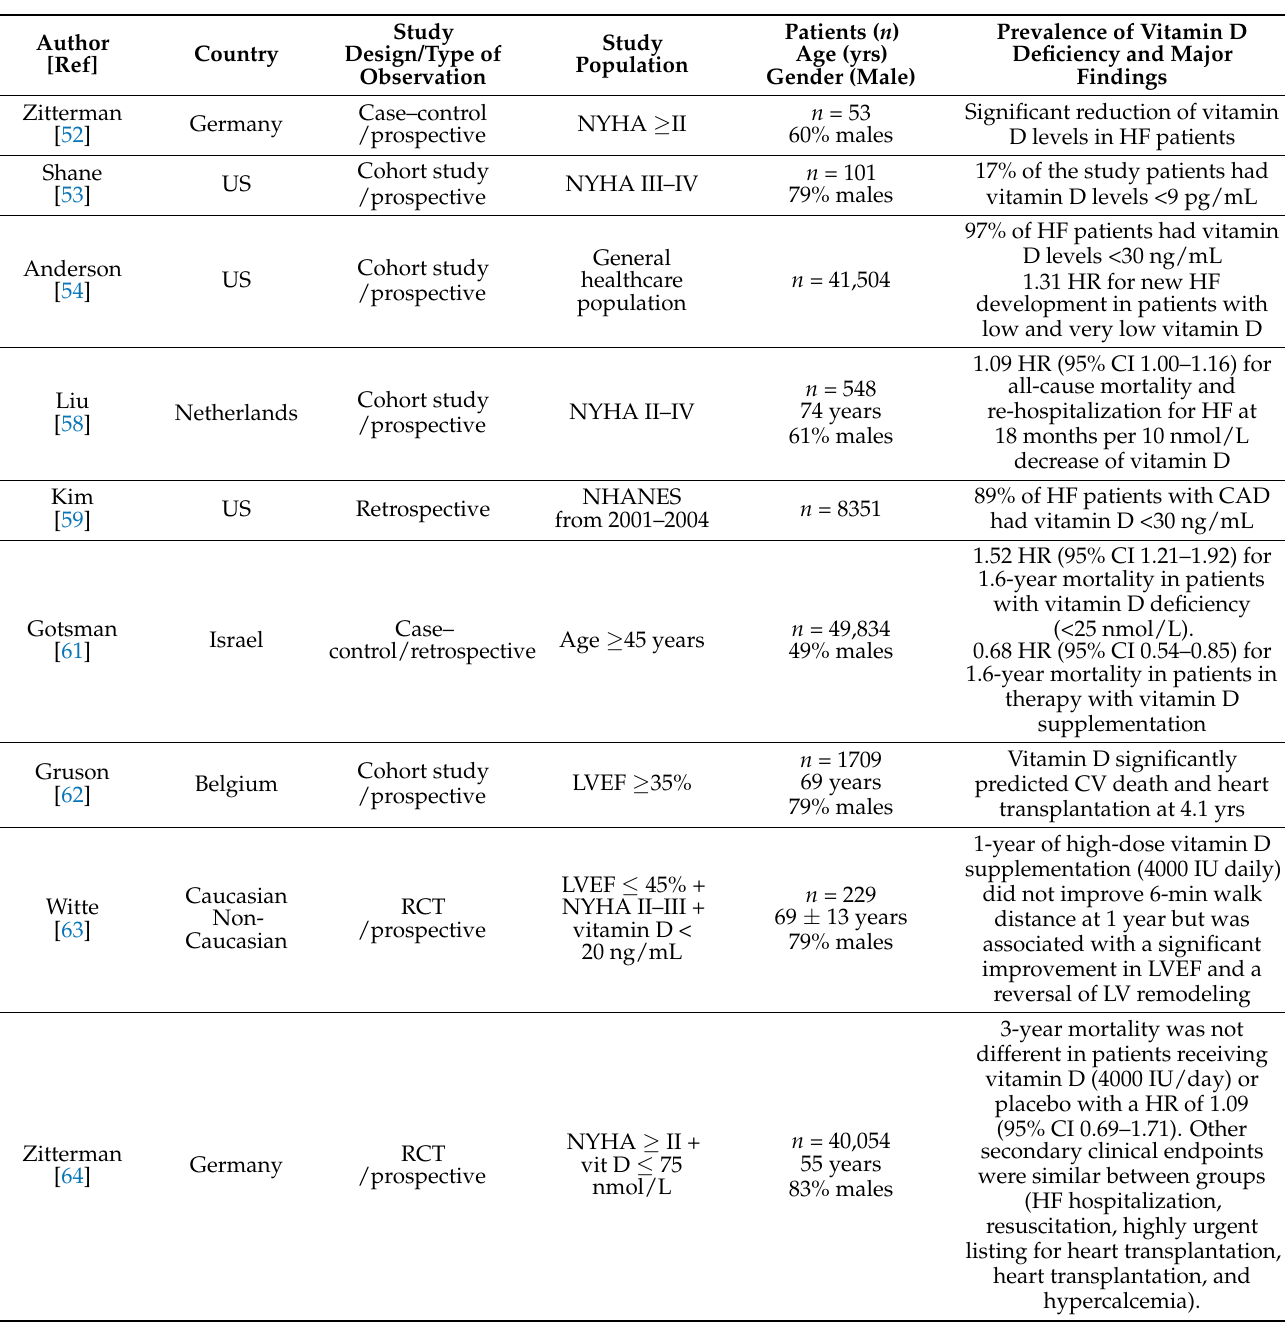
10,974 patients hospitalized with HF and with low vitamin D levels [57]. In another study, progressively lower vitamin D levels were independently associated with higher HF hospi- talization and all-cause mortality rates in 548 HF patients followed-up for 18 months [58]. Several other studies focusing on ambulatory or hospitalized HF patients confirmed the close association between vitamin D deficiency and worse prognosis (Table 3). Table 3. Some of the major studies on the clinical relevance of vitamin D levels in patients with heart